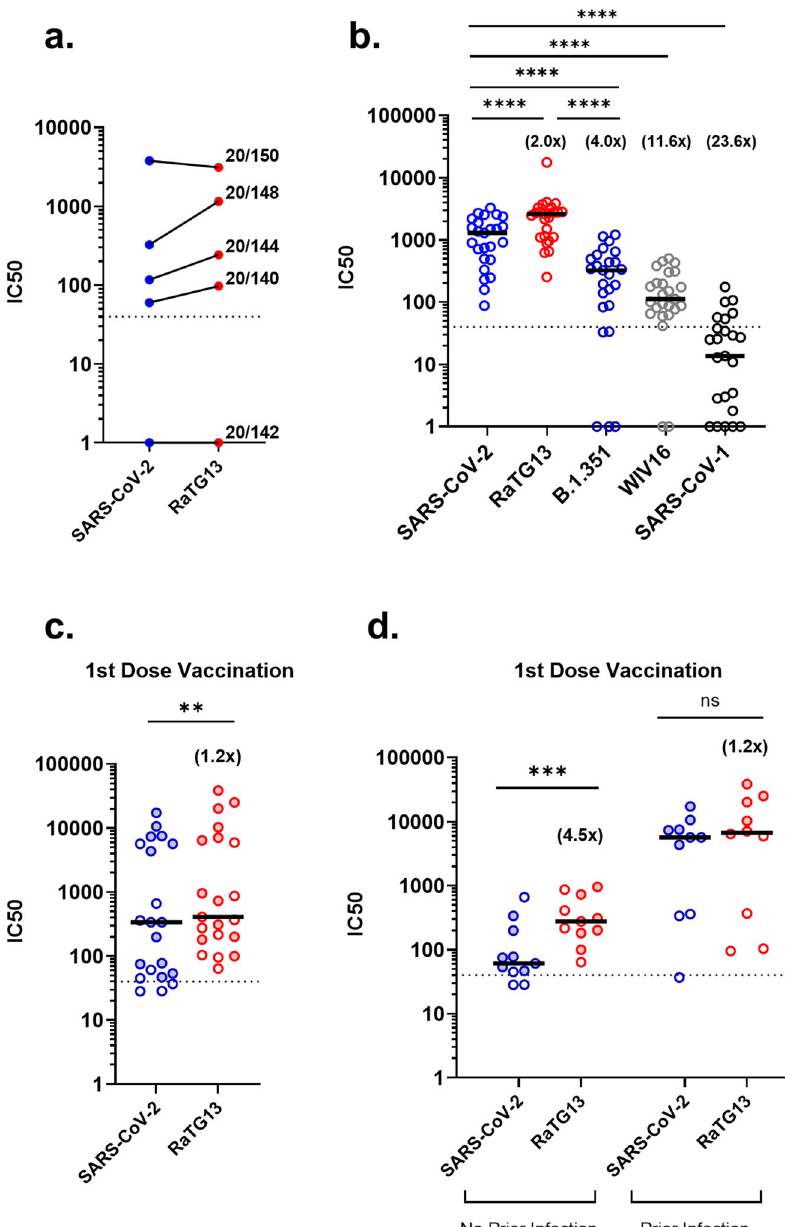
Fig. 1 Differences in neutralisation titres between SARS-CoV-2 and RaTG13 by pMN Assay. a Comparison of neutralisation titres between SARS-CoV-2 and RaTG13 using the WHO International Reference Panel for anti-SARS-CoV-2 immunoglobulin. Three of the four sera showed increased neutralisation titres against RaTG13. b Comparison of neutralisation titres between SARS-CoV-2 ( n = 25), RaTG13 ( n = 25, p = <0.0001), B.1.351 (Beta) ( n = 25, p = <0.0001) variant of concern, SARS-CoV-1 ( n = 25, p = <0.0001) and WIV16 ( n = 25, p = <0.0001) using convalescent sera derived from patients and healthcare workers. c Comparison of neutralisation titres between SARS-CoV-2 and RaTG13 against sera from single-dose vaccinated healthcare workers ( n = 21, p = 0.0016). d Differences in neutralisation titre from single dose vaccinated healthcare workers split by ‘ no prior infection ’ ( n = 11, p = 0.001) or ‘ prior infection ’ ( n = 10, p = 0.084) with SARS-CoV-2. Full circles denote healthcare workers vaccinated with BNT162b2 ( n = 12), whereas open circles denote vaccination with AZD1222 ( n = 9). Numbers in brackets denote fold changes relative to SARS-CoV-2. Wilcoxon matched pairs signed rank tests were used in panels ( b ), ( c ) and ( d ). Dotted lines in graphs denote the assay ’ s lower limit of detection. IC50 was calculated by fi tting a non-linear regression curve using Graphpad Prism 8 software. All n values constitute of biologically independent